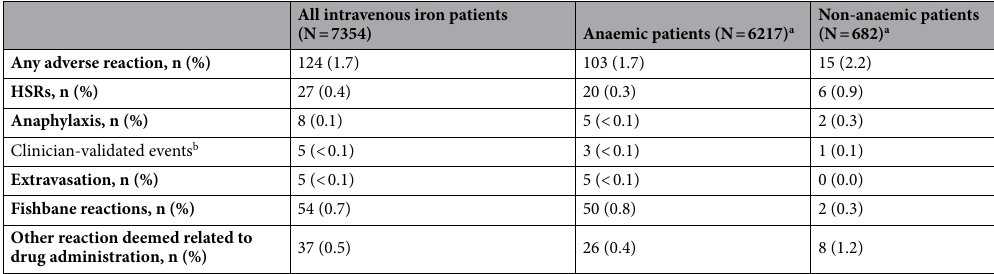
Table 2. Adverse reactions following FDI treatment (all courses). HSR hypersensitivity reaction, N number of patients, n number of patients with event. a Anaemia status at baseline was unknown for 455 patients. b The data presented reflect the classification of events after the process of review and validation by clinicians, during which some anaphylaxis events were recategorised into one of the other four groups.